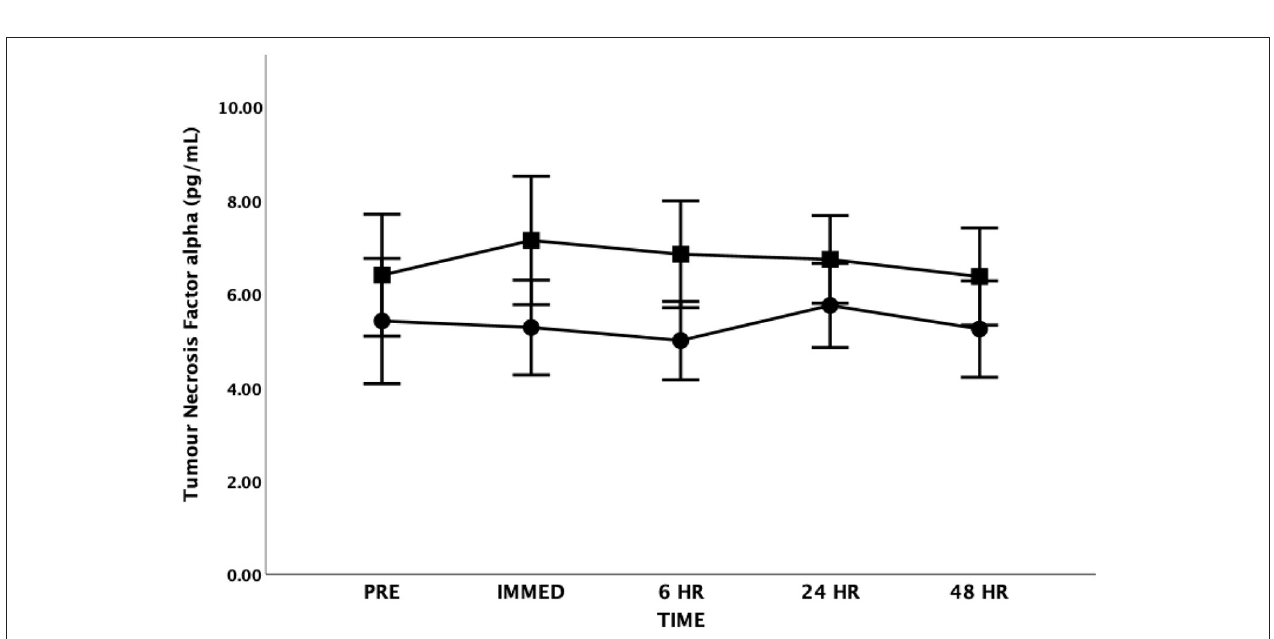
FIGURE 5 | Tumor Necrosis Factor-alpha (TNF- α ) as a function of time. Means ± SD. Circle = Steady State; Square = Interval. Error Bars = ± SEM.